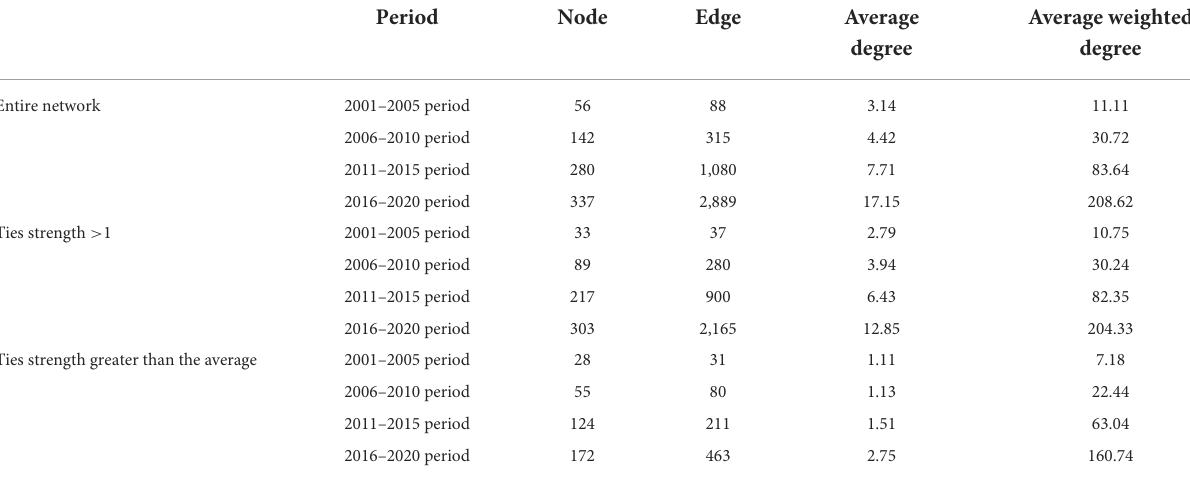
TABLE 1 Evolution of the statistical characteristics of the Chinese national urban biomedicine innovation network.